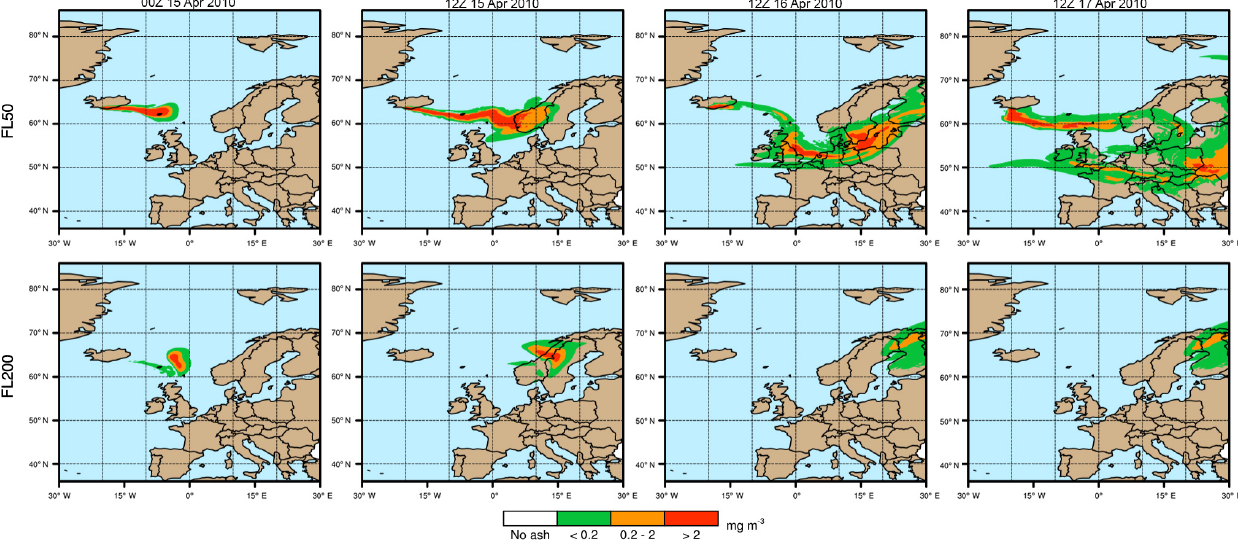
Figure 7. Ash hazard aviation guidelines applied for 2010 Eyjafjallajökull application over time. Zones of low (green, ash concentra- tion < 0.2mgm − 3 ) , moderate (orange, ash concentration between 0.2 and 2mgm − 3 ) , and high (red, ash concentration above 2mgm − 3 ) concentration are displayed for FL50 (top) and FL200